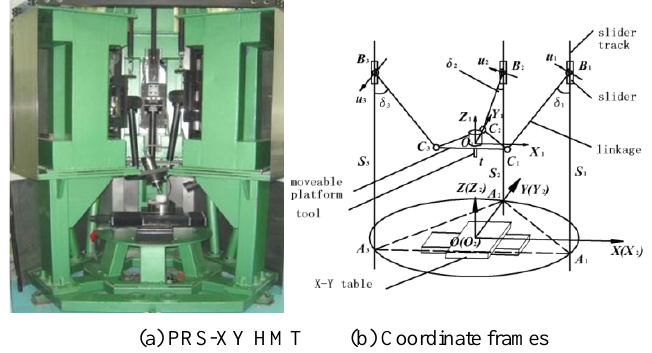
(a) PRS-XY HMT (b) Coordinate frames Fig. 1. PRS-XY HMT object and its Coordinate